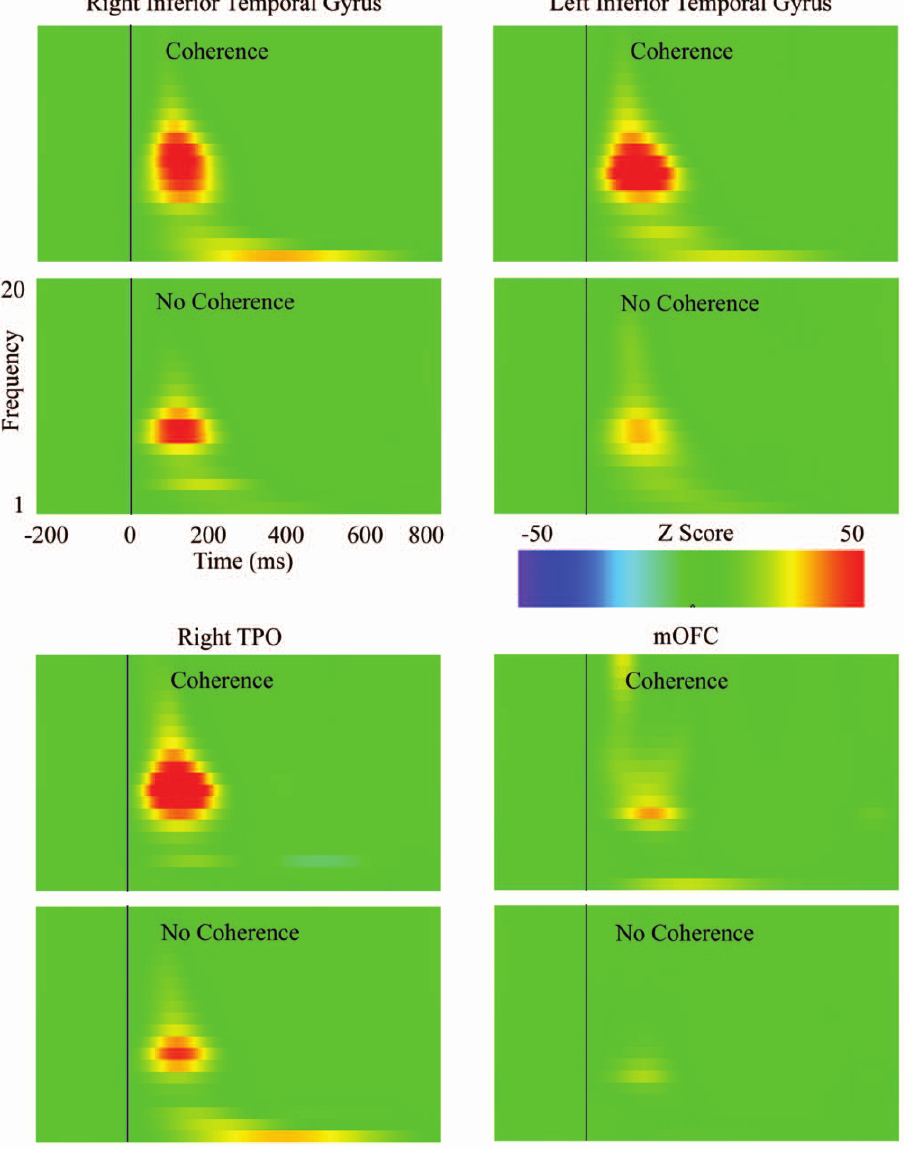
Figure 5. Time-Frequency plots of evoked oscillatory activity between 1–20 Hz. Energy increases and decreases after stimulus onset (time 0) are defined as standard deviations from the baseline period ( 2 200–0